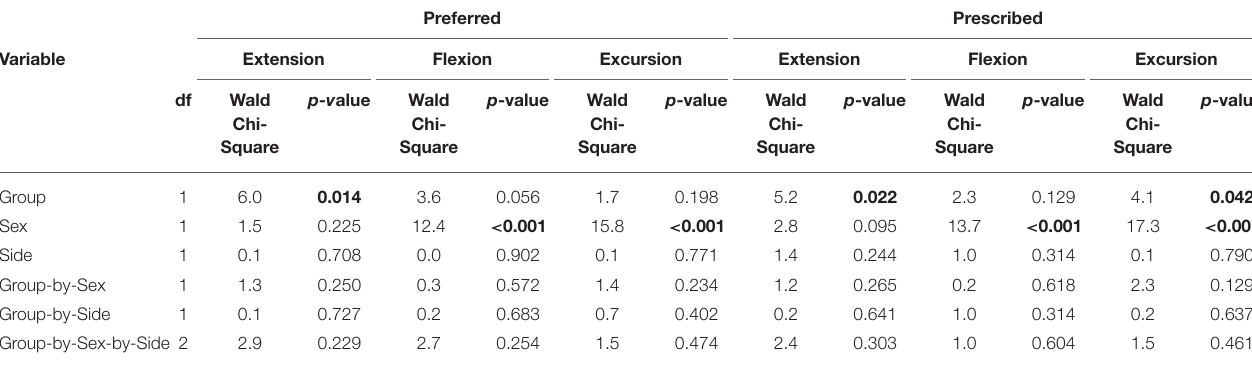
TABLE 3 | Results of linear regression with generalized estimating equation correction for each dependent variable (hip extension, flexion, and excursion) at the self-selected preferred walking speed and the prescribed (1.25 m/s) walking speed.